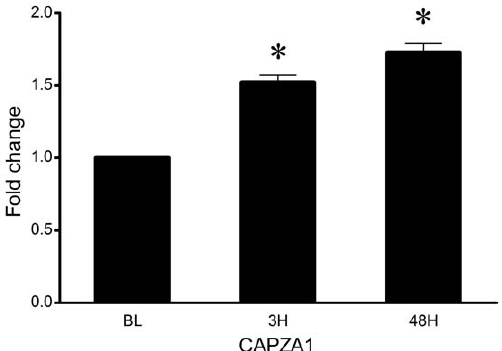
Figure 2. Expression fold changes in mRNA expression of CAPZA1 in muscle from baseline after exercise protocol. 3H=3 hours post exercise, 48H=48 hours post exercise. N=18. Values are mean 6 SEM. *Significant difference vs. baseline when collapsed across supplementation (P , 0.05).